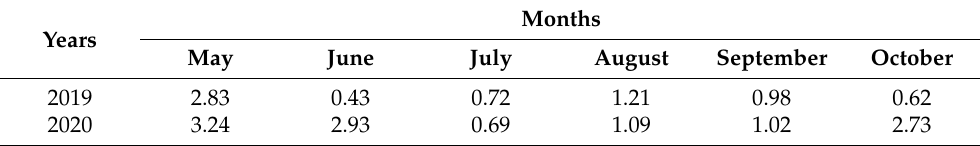
Table 3. Hydrothermal conditions during carrot growing